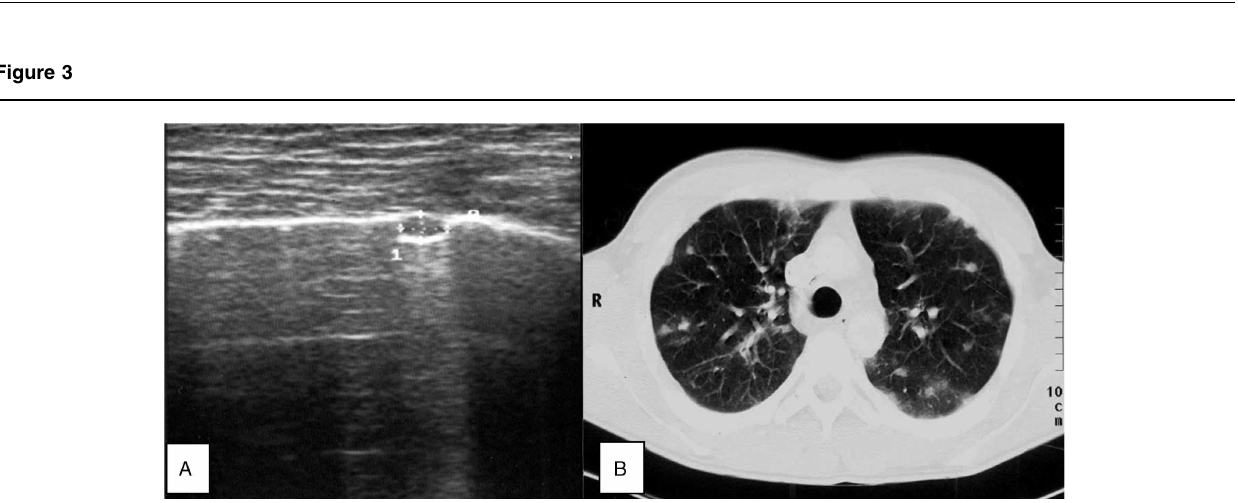
(a) Lung ultrasound showing four B lines arising from the pleural line with distance between the two B lines of about 7mm. (b) Multidetector computed tomography (MDCT) of the chest showing bilateral subpleural reticular and honeycomb shadows in a patient with idiopathic pulmonary